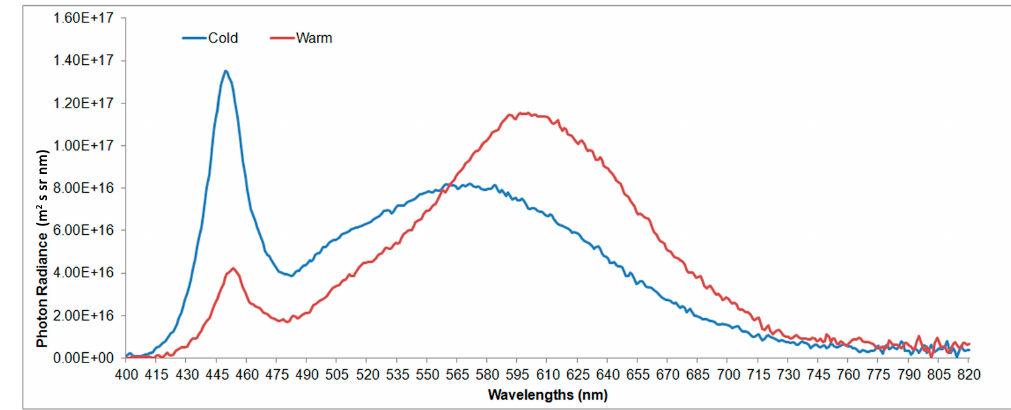
Figure 2. Spectral photon radiance distribution of the artificial LED lighting used in the two experimental conditions. experimental